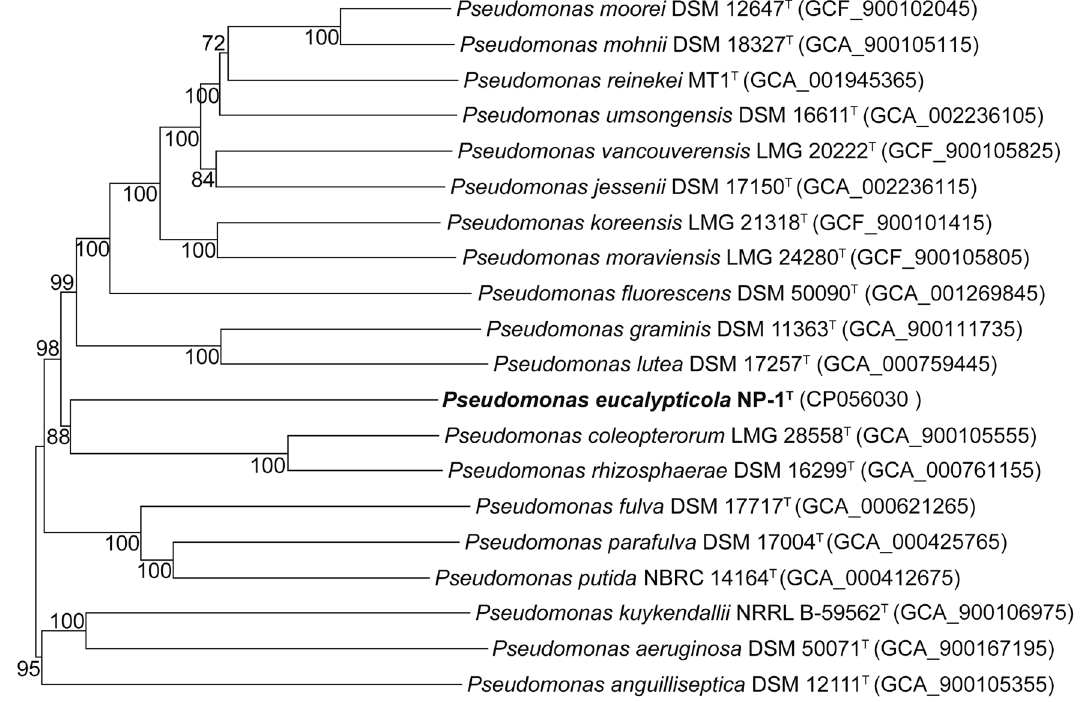
Figure 3. Phylogenomic tree of strain NP-1 T and related type strains of the genus Pseudomonas available on the TYGS database. The tree inferred with FastME 2.1.6.1 based on GBDP distances calculated from the genome sequences. The branch lengths are scaled in terms of the GBDP distance formula d 5 . The numbers above the branches show the GBDP pseudo-bootstrap support values > 60% from 100 replications, and the average branch support is 94.6%.